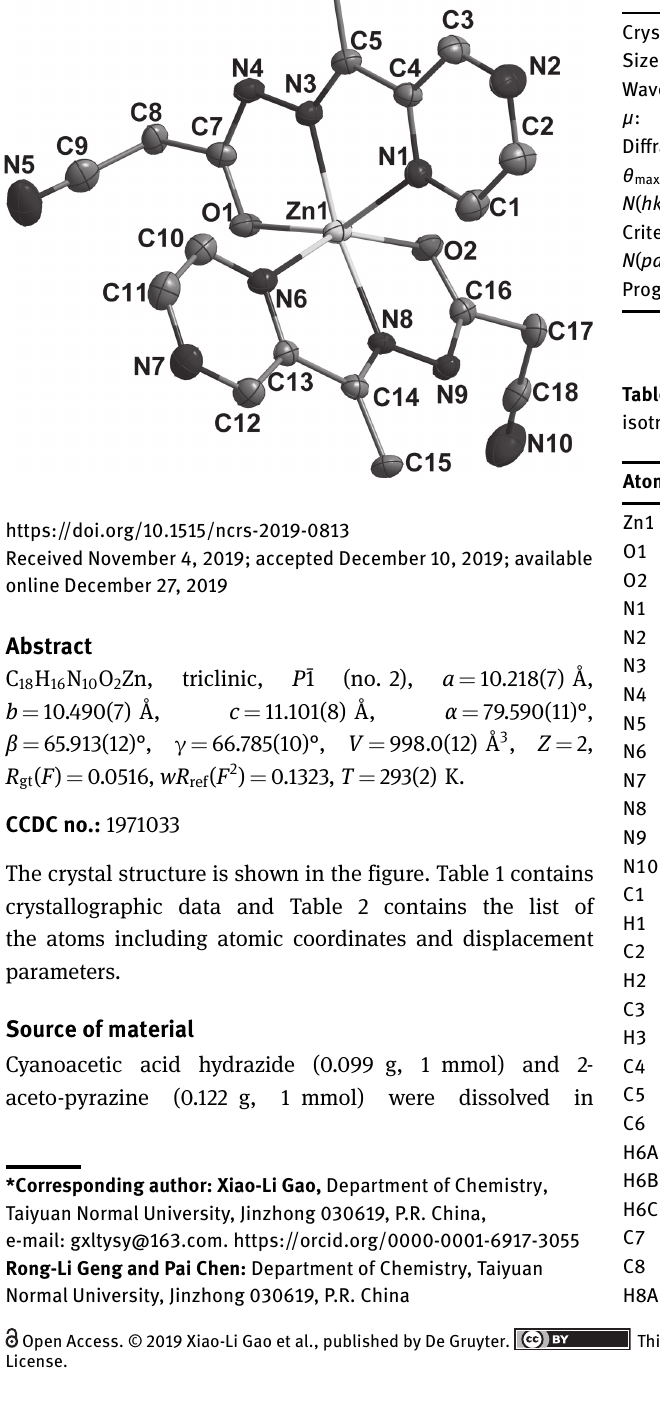
Table 1: Data collection and handling.